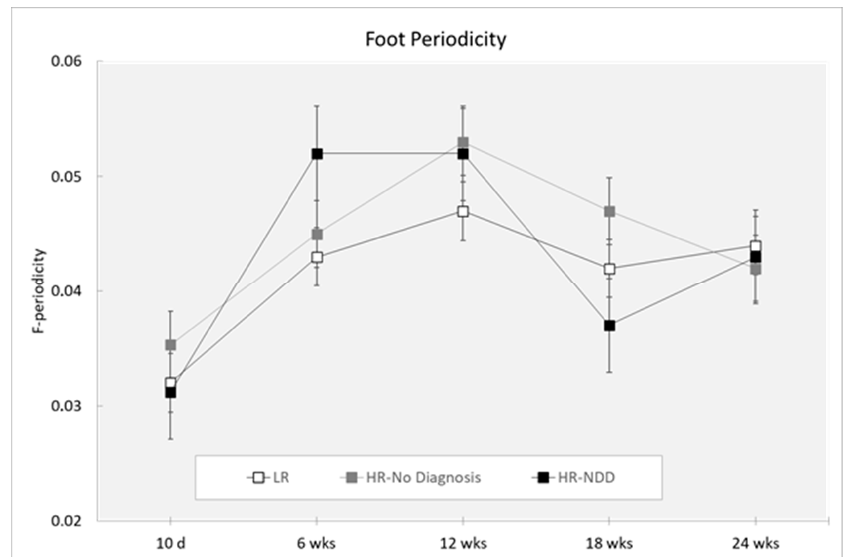
Figure 8. Foot periodicity in a 3-min session, measured at 10 days and 6, 12, 18, and 24 weeks in three groups of infants (LR, n = 53; HR-no diagnosis, n = 32; HR-NDD infants, n = 18). d = days; wks = weeks. Data are expressed as mean ± SEM. Periodicity is a nondimensional value.